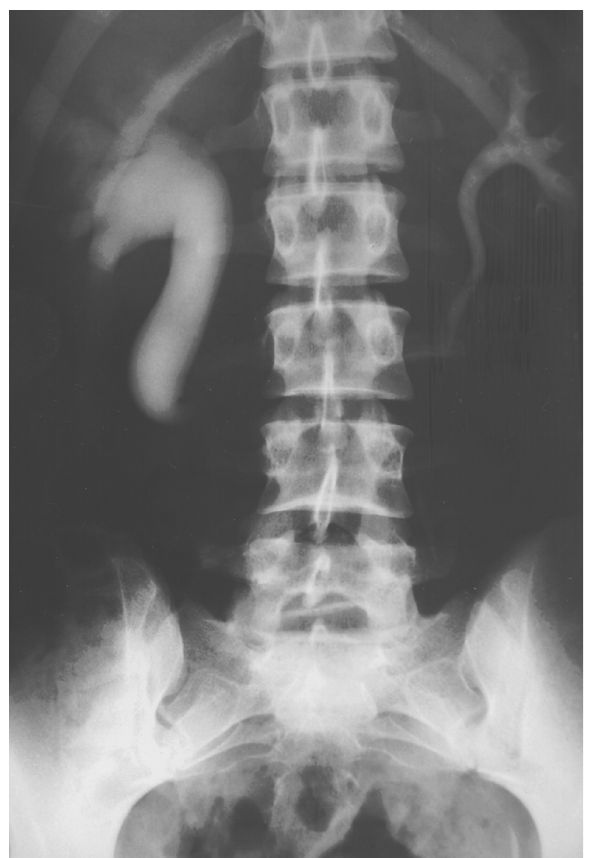
Figure 1 – Excretory urography showing proximal uretero-hy- dronephrosis and typical “J” configuration of retrocaval ureter.